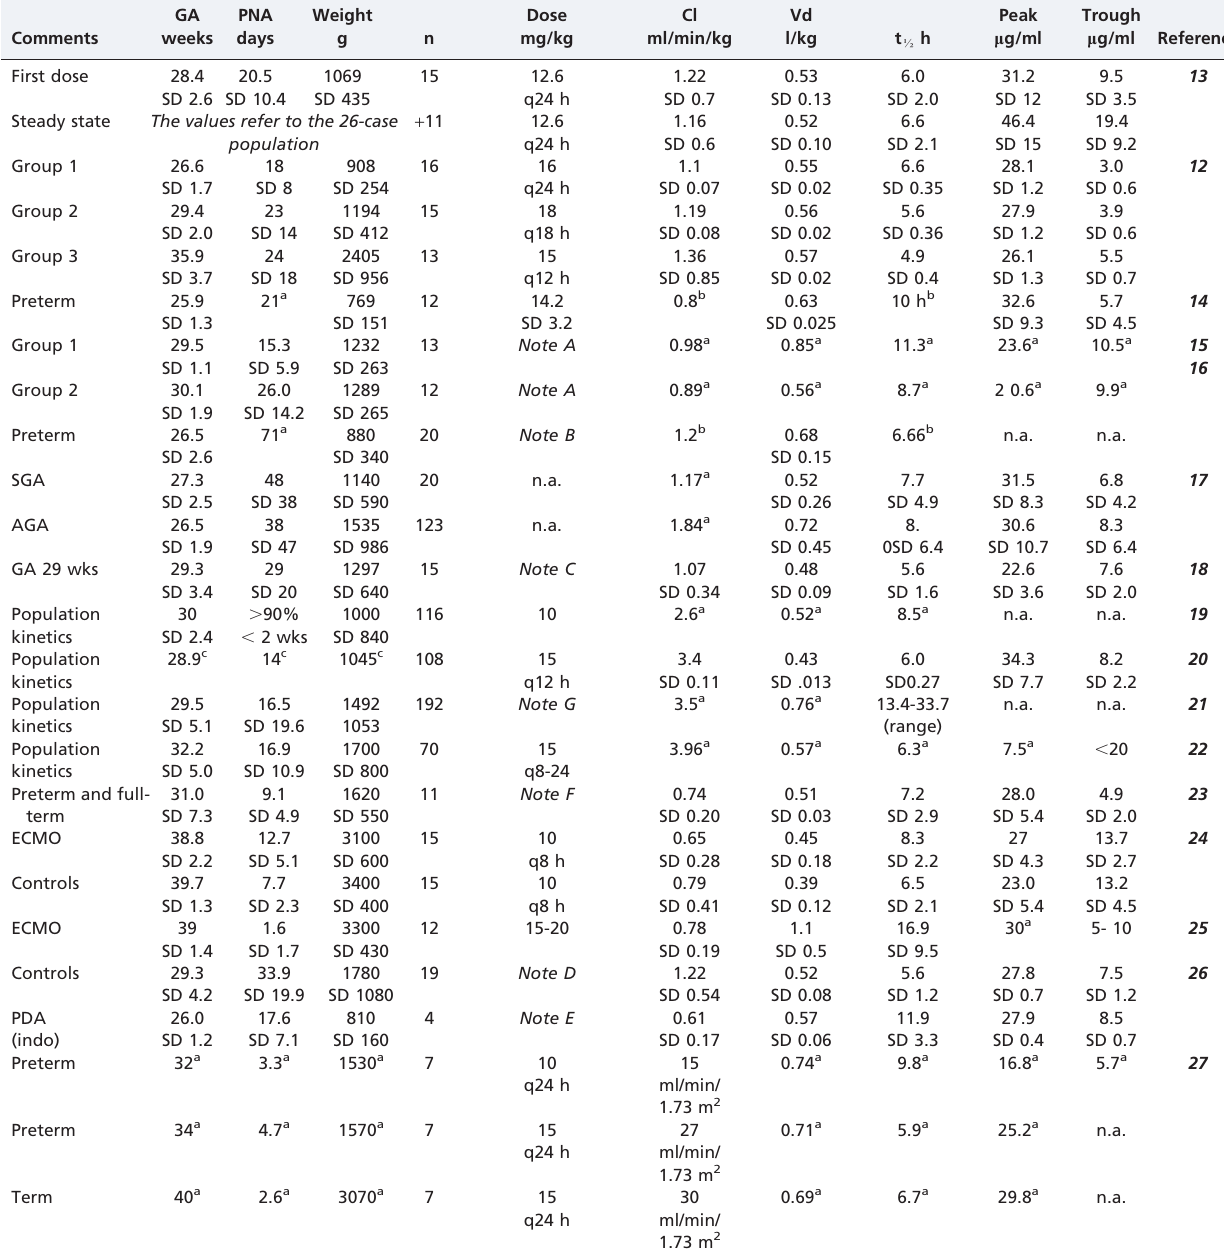
Table 4 - Neonatal demographic data and pharmacokinetic parameters of vancomycin therapy. The results are presented as the mean ¡ standard deviation unless otherwise